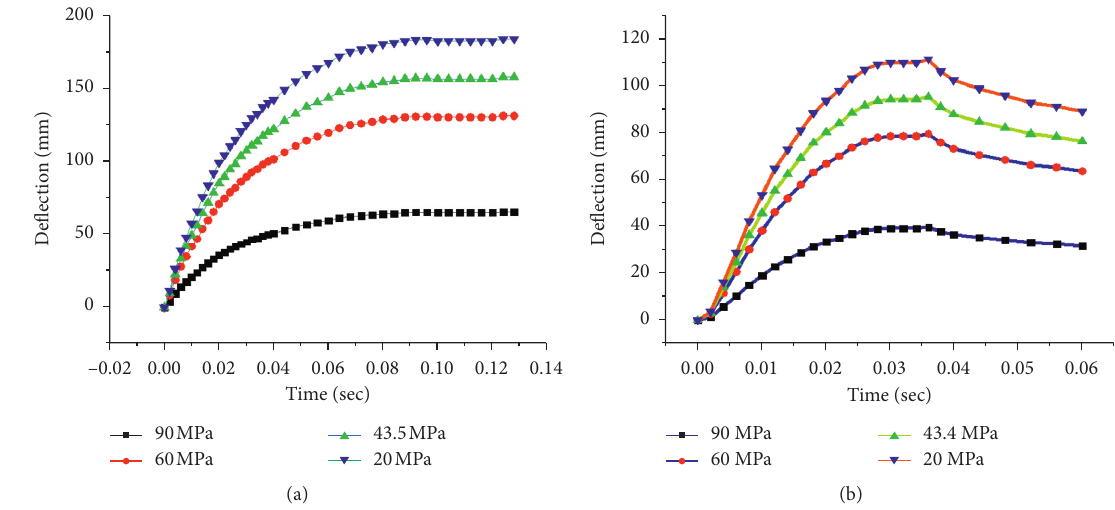
Figure 18: Effect of concrete strength on the deflection time history curve of CFRPRC members. (a) FH2. (b)